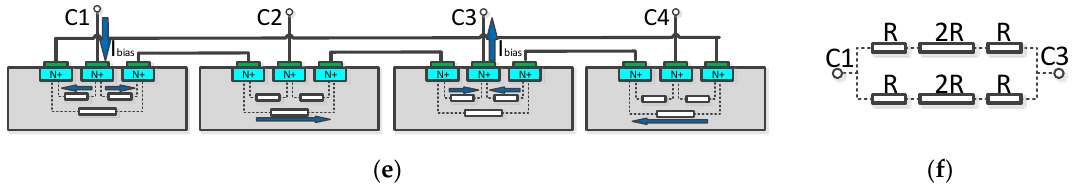
Figure 5. ( a ) The current flow path for a double three-contact device at phase 0; ( b ) the equivalent model for a double three-contact device; ( c ) the current flow path for the orthogonal coupling structure at phase 0; ( d ) the equivalent model for the orthogonal coupling structure; ( e ) the current flow path for a low-offset structure at phase 0; ( f ) the equivalent model for a low-offset structure.